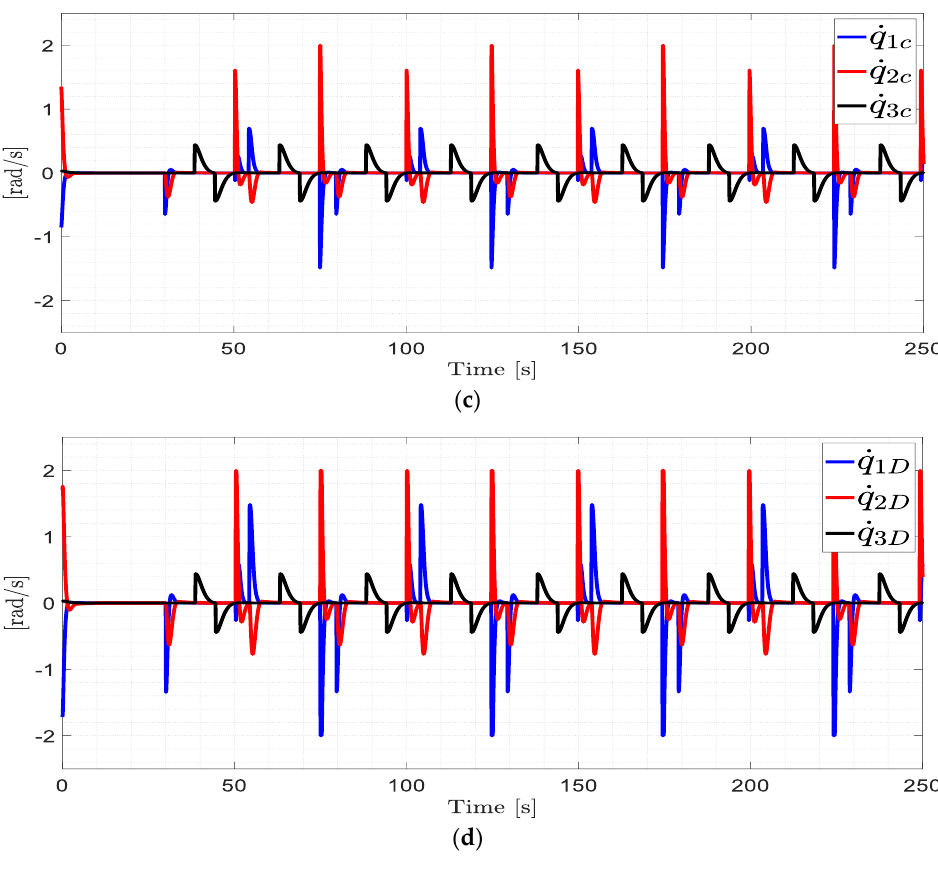
Figure 12. Movements of the Scara A robot in the virtualized industrial environment, when per- forming the bottle selection task; ( a ) Desired and real robot operating end positions; ( b ) Distance between the desired positions and the real position of the robot ρ A ( t ) < (cid:107) lated by the kinematic controller; ( d ) Maneuverability velocities calculated by the dynamic compen- sator.